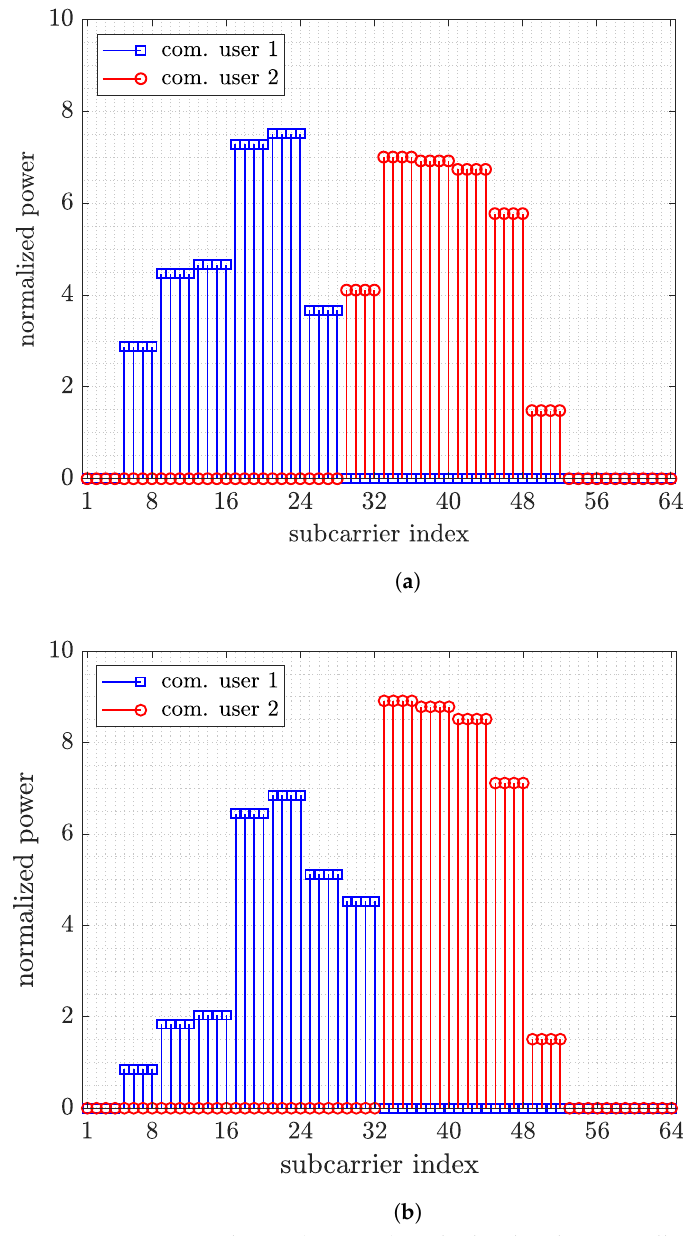
Figure 7. Cooperative design ( γ = 0.9) with chunk subcarrier allocation. ( a ) Overall commu- nication MI maximization ( I ( y rad ; h | s ) = 28.17, I ( y com,1 ; g 1 | s ) = 22.50, I ( y com,1 ; g 2 | s ) = 16.58). ( b ) Worst-case communication MI maximization ( I ( y rad ; h | s ) = 28.17, I ( y com,1 ; g 1 | s ) = 17.71, I ( y com,1 ; g 2 | s ) =